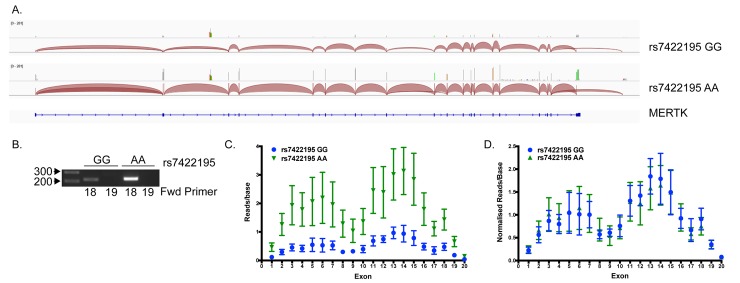
The MERTK gene contains a novel alternative final exon but usage is not genotype-dependent.(A) Exon junctions in RNA sequencing data were visualised using IGV_2.3.35. Representative junction maps for a low (rs7422195 GG) and high (rs7422195 AA) expressing sample are shown. Each shows the presence of a junction from exon 18 to a putative novel alternative final exon excluding exon 19. (B) RT-PCR analysis of a high and low expressing sample show the presence of this exon only in combination with exon 18 and not exon 19. (C) Exon usage analysis shows overall increased expression of each exon in samples homozygous for the rs7422195 minor (A) allele, but no difference in exon usage following normalisation for overall expression level (D).